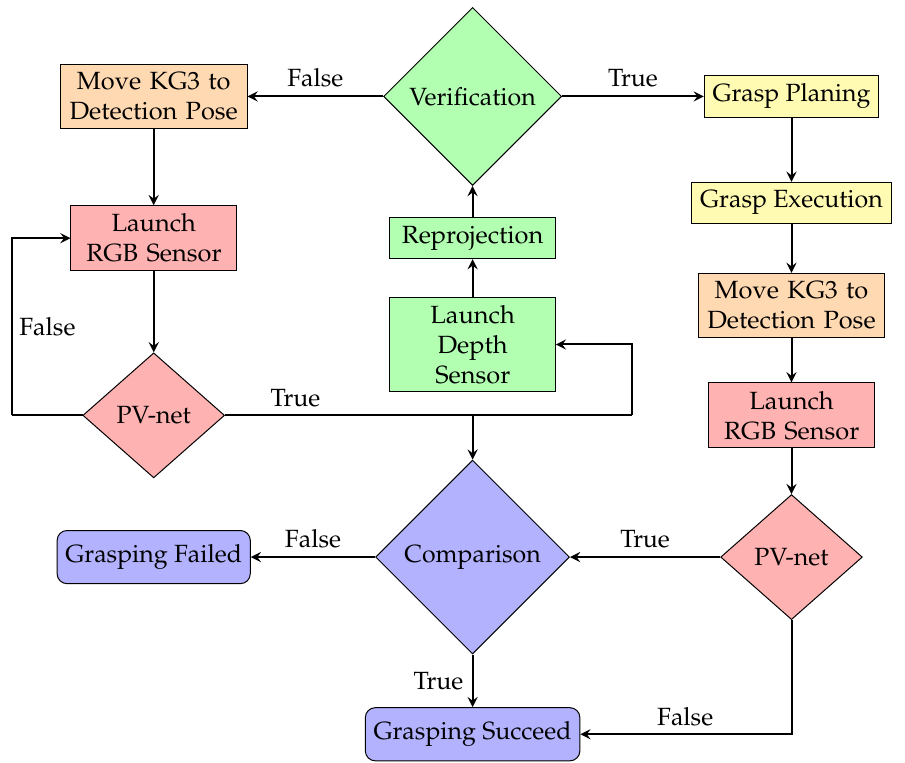
Figure 4. The architecture of our proposed autonomous 6D grasping system. The red parts denote the estimation of object 6D pose via PV-net, green parts denote the judgment of the object and its photos and purple parts denote the judgment of the successful operation of the grasping